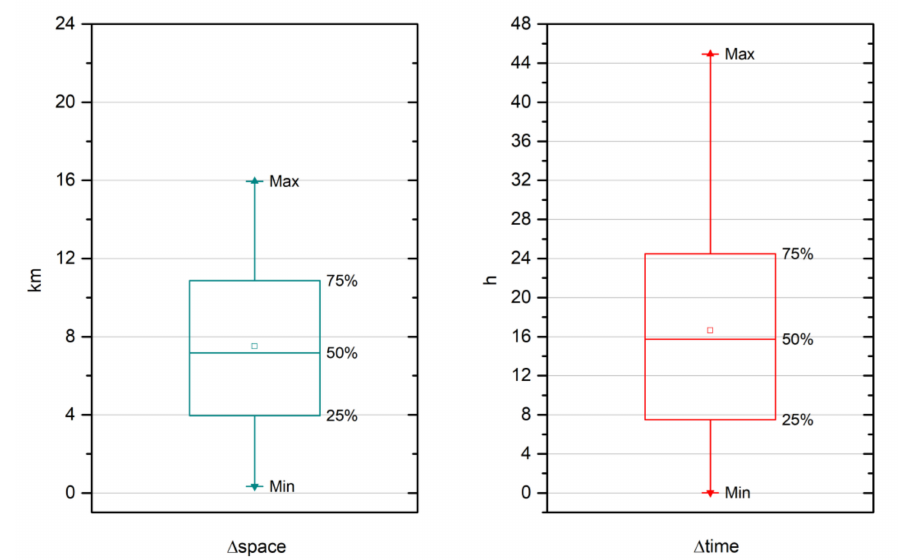
Figure 5. Distances in space ( left ) and time ( right ) between collected Argo and CTD profiles (mean values are indicated by empty squares).